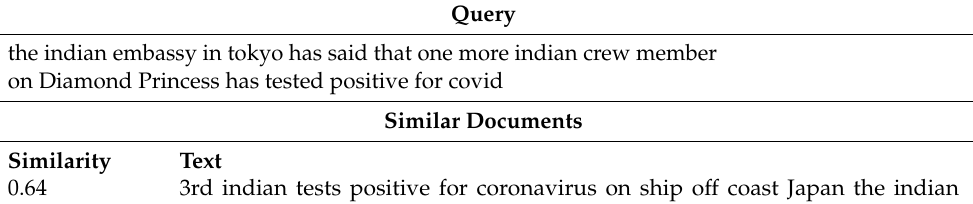
Table 2. Example of similar document selection. The query is taken from the CoVID19-FNIR dataset while the similar documents are the ones with the highest cosine similarity among all the documents in the coronavirus news dataset